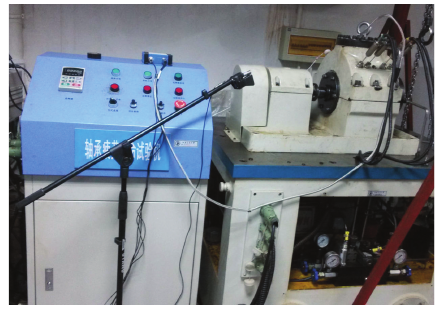
Figure 9: T20-60nF bearing fatigue life tester.